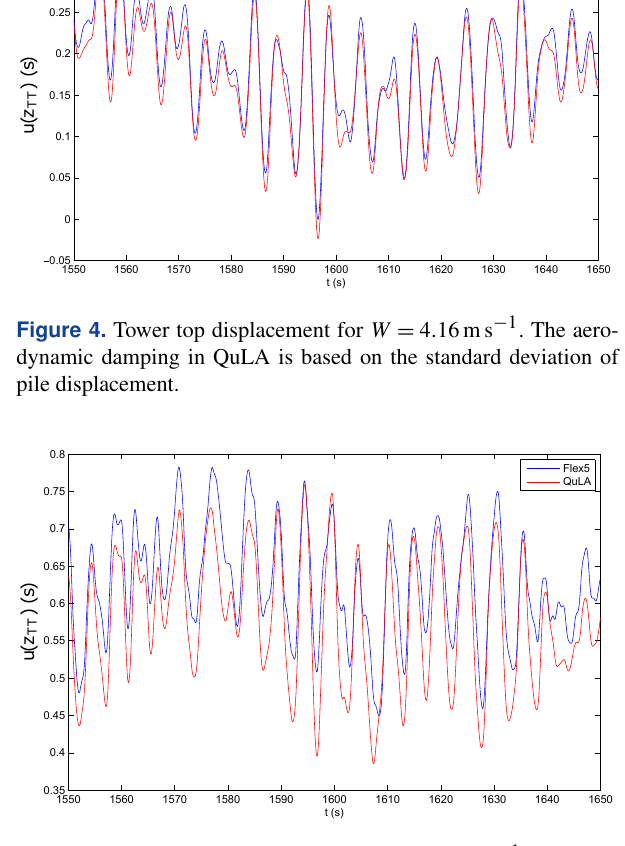
Figure 5. Tower top displacement for W = 14 . 55ms − 1 . The aero- dynamic damping in QuLA is based on the standard deviation of pile